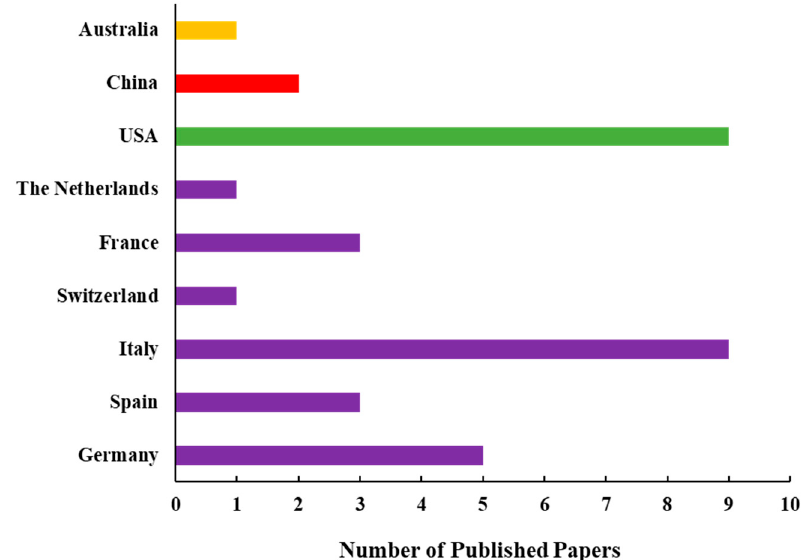
Figure 2. Bar graphs represent the country-wise ground-based SIF studies discussed in this review which were published until 2019. Color of the bar represents different continents (Yellow = Australia, Red = Asia, Green = North America, Violet = Europe). Note: the first author and/or corresponding author (if different) affiliations were used as the main criterion on defining the country of origin of the paper.